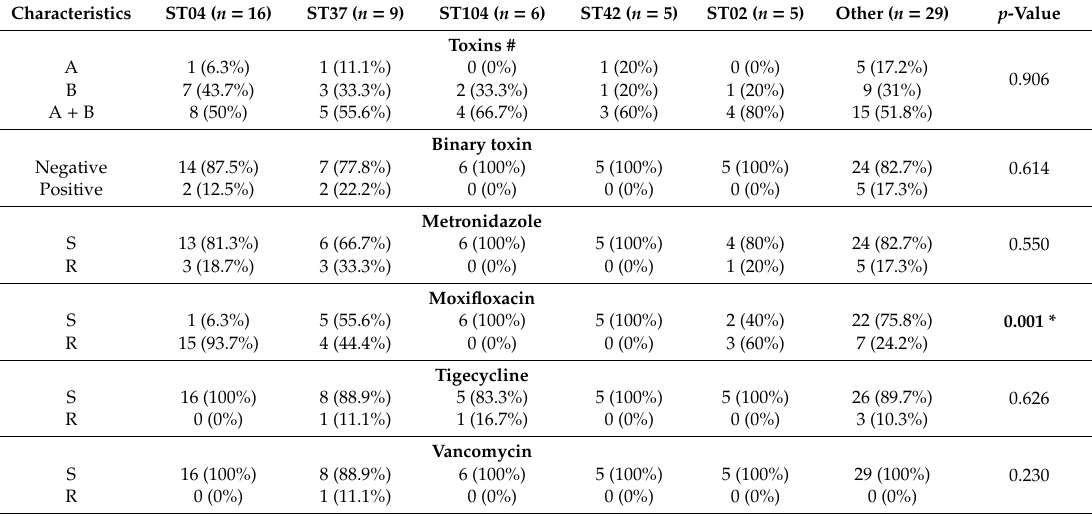
Table 4. Associations between ST and bacterial